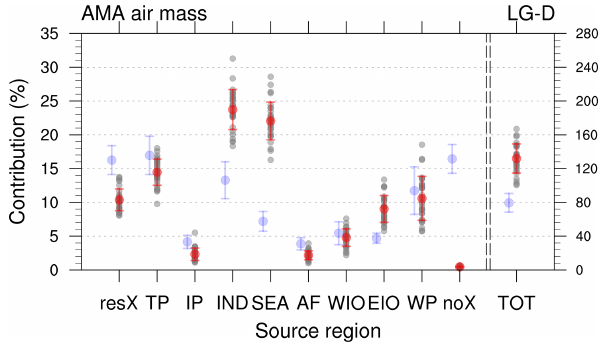
Figure 14. Contributions of PBL sources to the AMA around 150hPa for 1981–2010 from the free-running LG-D simulation. Mean values are given as red dots, red whiskers denote the inter- annual standard deviation and individual years are indicated as grey dots. For TOT the right axis denotes the total number of trajecto- ries in units of 10 3 trajectories. For comparison, faint blue dots and whiskers denote the values from the TRJ